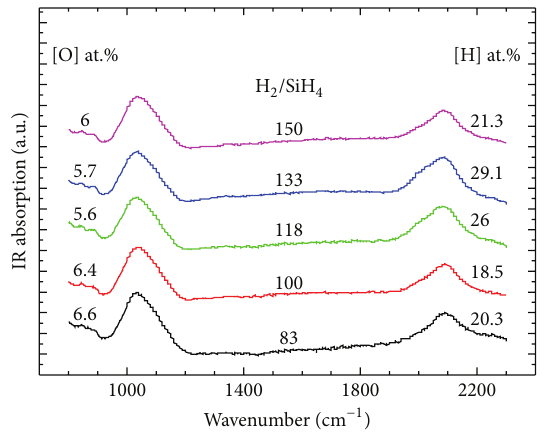
Figure 7: Infrared absorption spectra of p- 𝜇 c-Si 1−𝑥 O 𝑥 :H films as a function of H 2 /SiH 4 ratio with oxygen and hydrogen concentration.